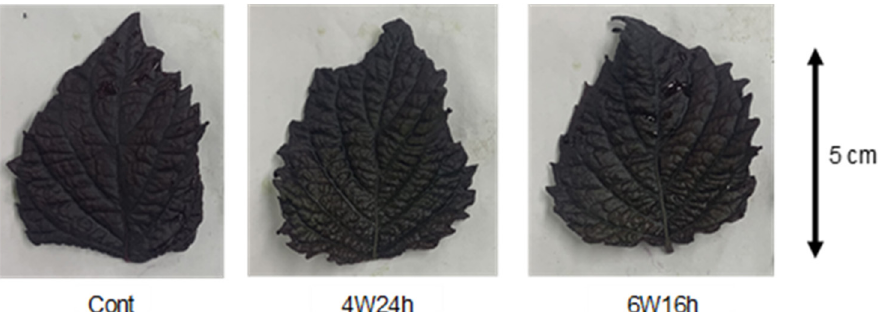
Figure 6. The 4th leaves of red perilla were grown for 3 d under different UV irradiation intensities (experiment 2). Plants were exposed to UV-B irradiation at 0 W m − 2 (control), 4 W m − 2 at continuous irradiation (4 W 24 h), and 6 W m − 2 for a 16 h light period (6 W 16 h).